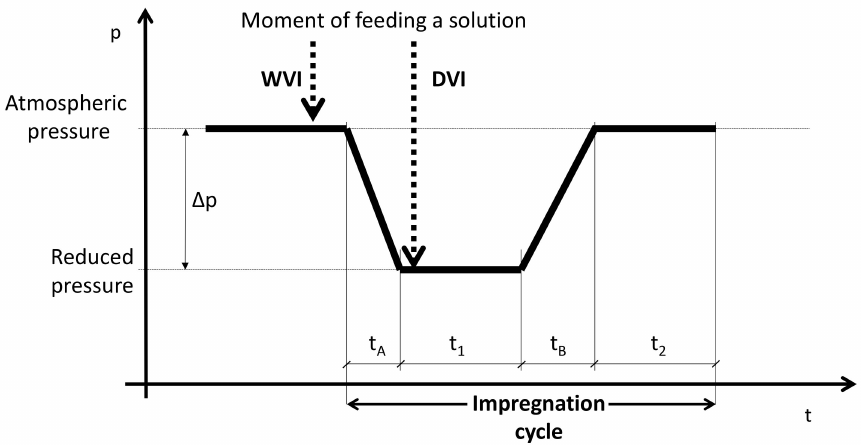
Figure 1. The process of vacuum impregnation and its individual phases: Phase 1—pressure change during time t A , phase 2—vacuum maintenance during time t 1 , pressure change during time t B , phase 4—relaxation during time t 2